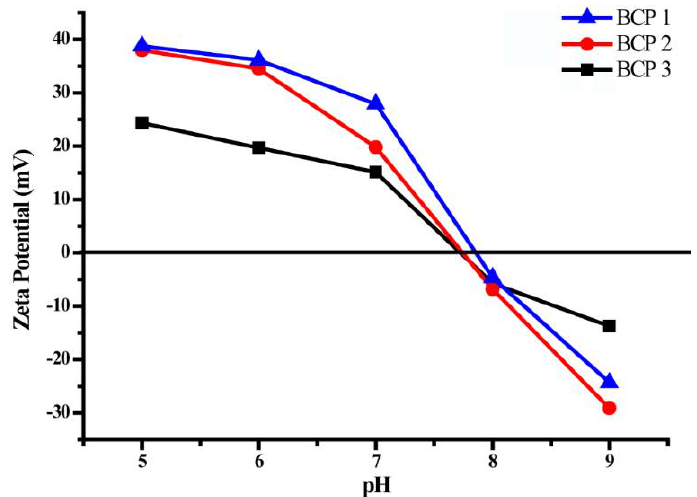
Figure 5. Zeta potential of amphiphilic block copolymers aggregates BCP1, BCP2 and BCP3.